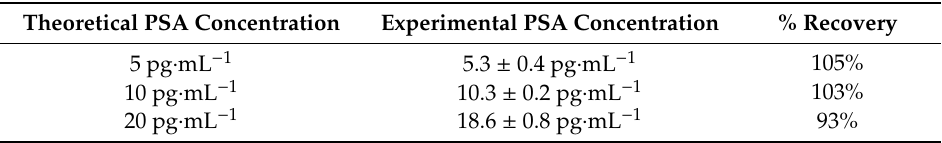
Figure 8. Confocal microscopy images of small areas (230 × 230 μ m 2 ) of the microscope slide wells obtained after the PSA QD ‐ based immunoassay, followed by gold deposition on the Mn ‐ ZnS QD tags at different PSA concentrations: ( a ) 0, ( b ) 5, ( c ) 10, and ( d ) 20 pg ∙ mL − 1 PSA used for methodology validation. Table 2. PSA quantification and recovery for samples containing close PSA concentrations. Uncertainty associated corresponds to 1SD ( n = 2